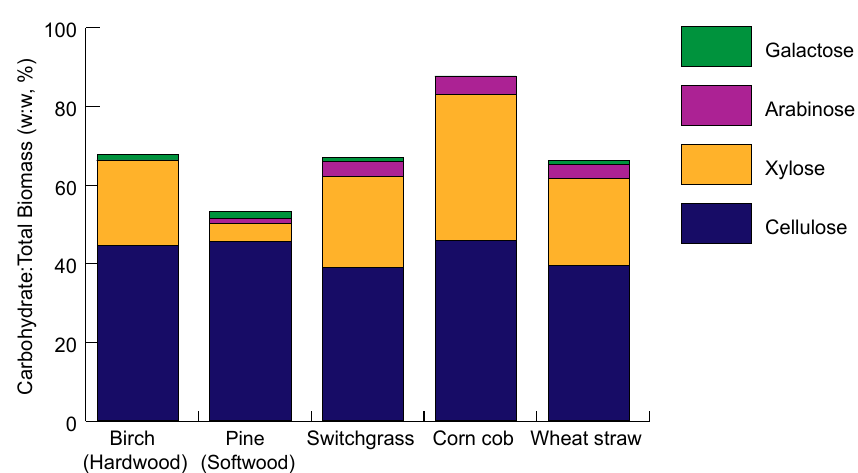
Figure 2. Major carbohydrate composition of potential sources of lignocellulosic feedstock, birch [35], pine [35], switchgrass [36], corn cob [37], and wheat straw [38]. In addition to the sugars highlighted here, total biomass also includes lignin and minerals